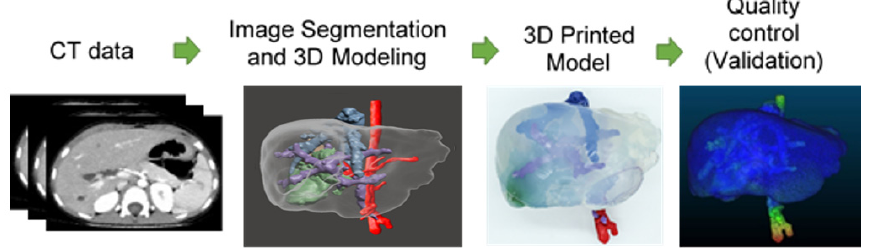
Figure 1. Graphical abstract representation of the high-level process followed in cases presented in this research.